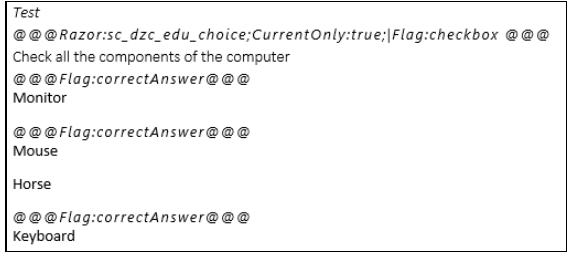
Fig. 2. “ Choice ” type interaction pseudocode.